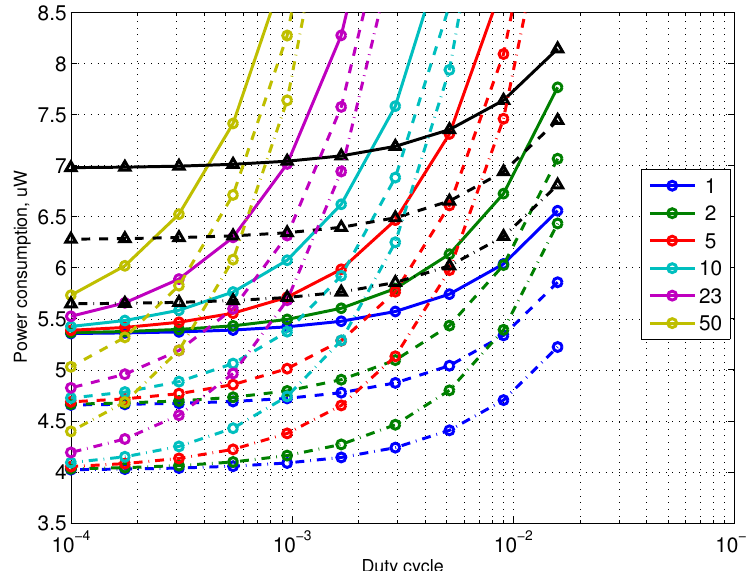
Figure 8. Detailed figure when M t = 1 and M r = 1, power consumption while operating with reloading the capacitor while operating with capacitor ( C s = 0.35 F). Non-WuR in black (without triangles), passive WuR in colors indicating number of nodes for different host duty cycles per node ( β (cid:48) w ). Semi-passive WuR in black with triangles. Line type indicates used SC leakage current model as